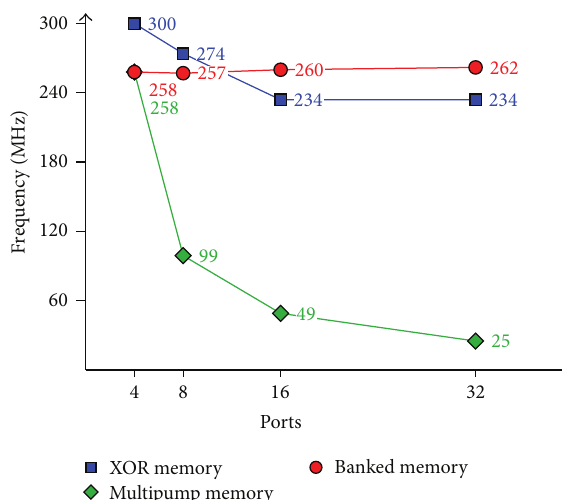
Figure 4: RAM block usage for XOR, multipumped, and banked memoriesasthenumberofportsisvaried.Weusedtheresultsofour